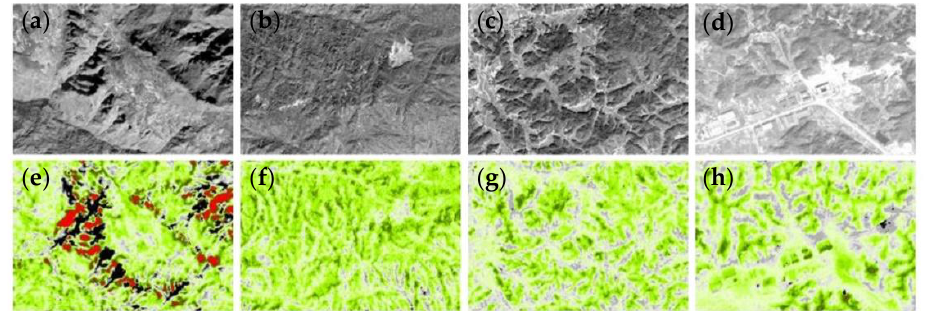
Figure 6. The ZY-3 nadir view images and the corresponding crude CHMs. The crude CHM’s legend is the same as Figure 5’s. Subgraphs ( a ) and ( e ) show the impact of shadows and steep terrain, with the positive error labelled in red and the negative error labelled in black. ( b ) and ( f ), ( c ) and ( g ), and ( d ) and ( h ) show the vertical information of different surface objects.